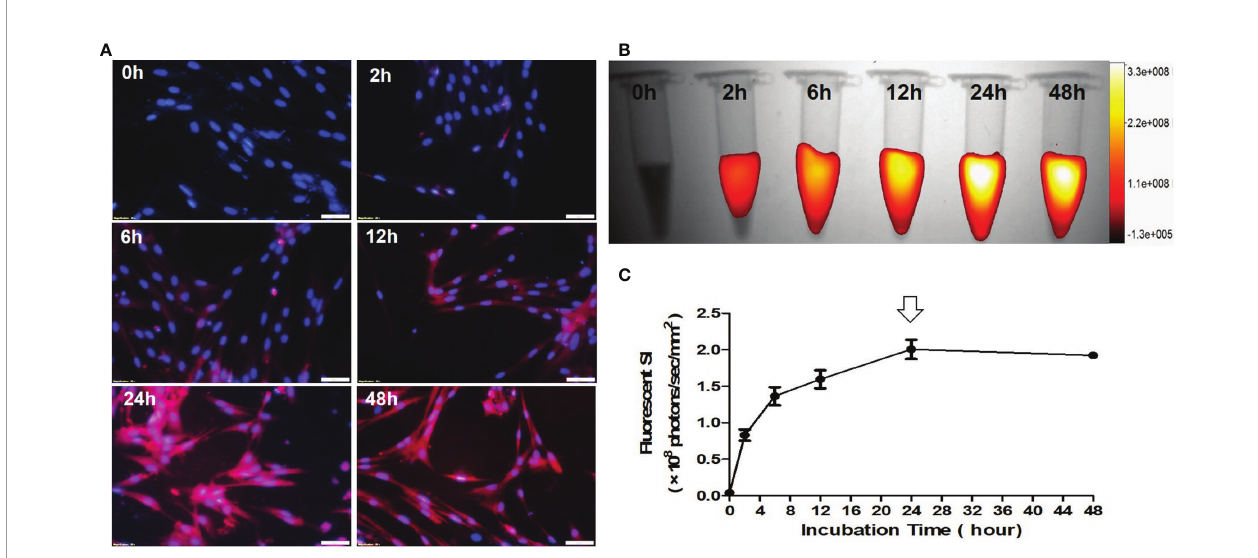
FIGURE 4 | Optimization of the detection time-window for optical imaging of indocyanine green (ICG)-treated VX2 tumor cells. (A) Fluorescence microscopic images of VX2 cells labeled by ICG with different incubation times from 0 h to 48 h, displaying that ICG-emitting pink fl uorescent signal becomes more intense as the incubation times increase (Scale bars, 50 m m). (B, C) Quantitative optical/X-ray images further demonstrate ICG SI becomes peek at 24 hours (arrow) as the optimum time window for suf fi cient ICG uptake by VX2